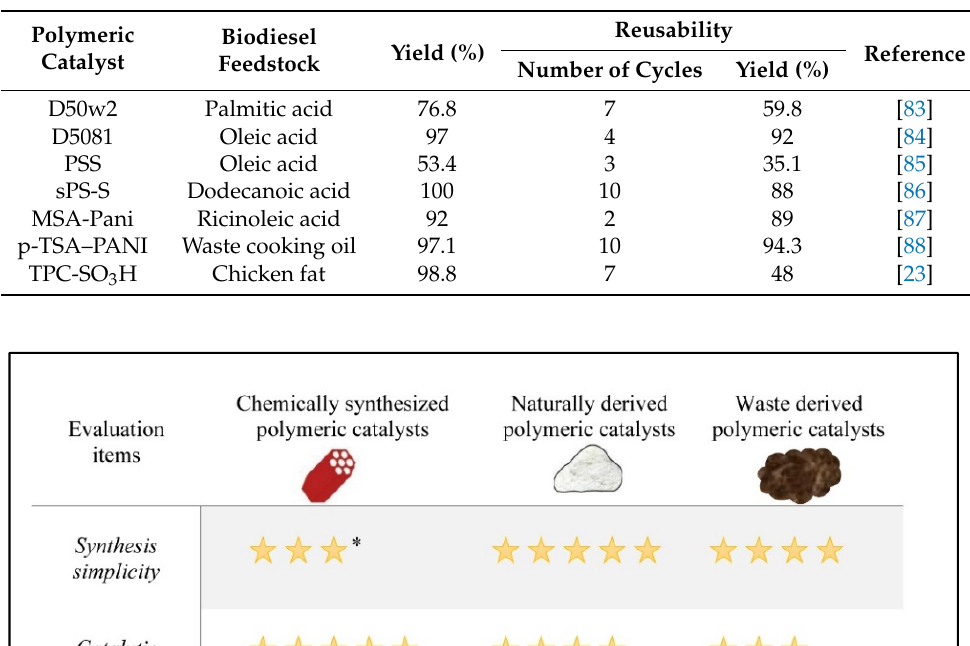
Table 6. Some of the waste derived polymeric catalysts.